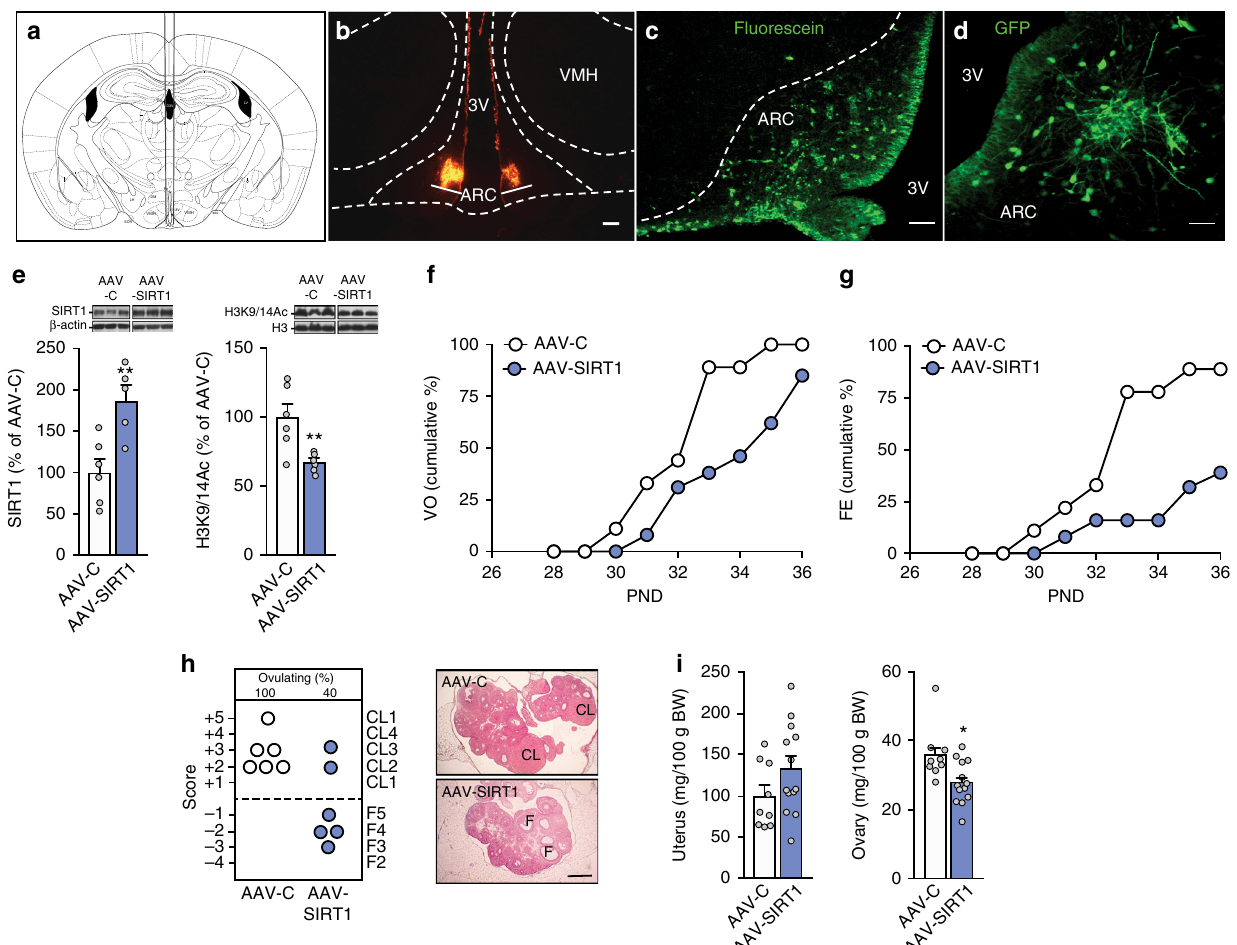
Fig. 5 Virogenetic overexpression of SIRT1 in the ARC delays pubertal timing. a Scheme illustrating the stereotaxic delivery of AAV to the ARC.